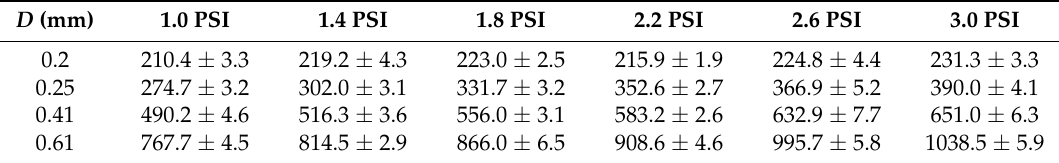
Table 2. The statistics of the measured diameters in different configurations (unit: μ m).